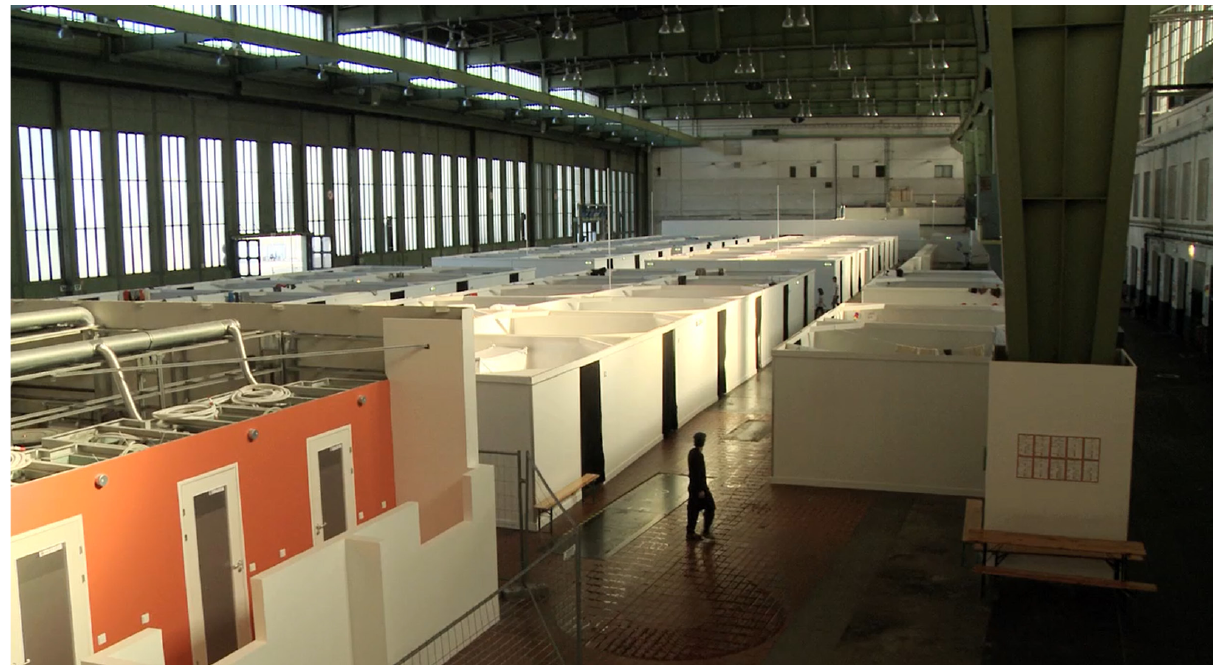
Figure 5. A perspective into the planned emergency shelter at the former Tempelhof airport in Berlin in 2016. Source: Misselwitz, taken in